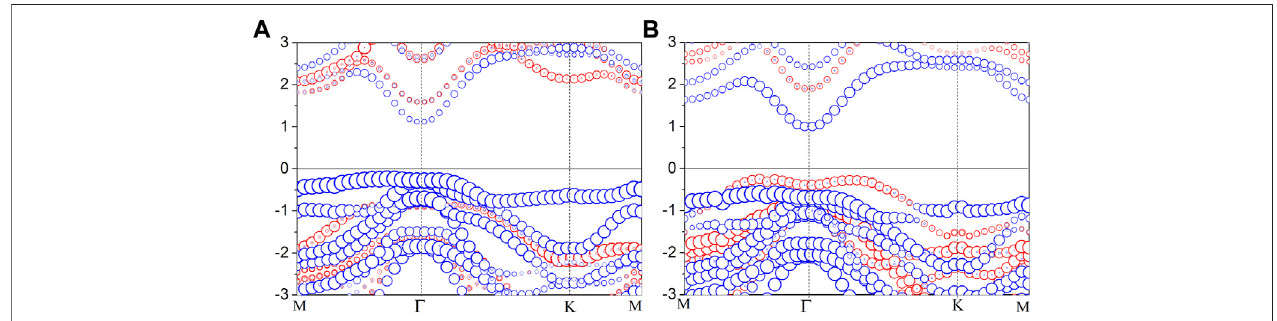
FIGURE3| Projectedbandstructuresof (A) In 2 Se 3 /InSe(up)and (B) In 2 Se 3 /InSe(down)heterostructurescalculatedbytheHSE06hybridfunctional.Theblueand red circles represent In 2 Se 3 and InSe components, respectively. The Fermi level is set to zero.